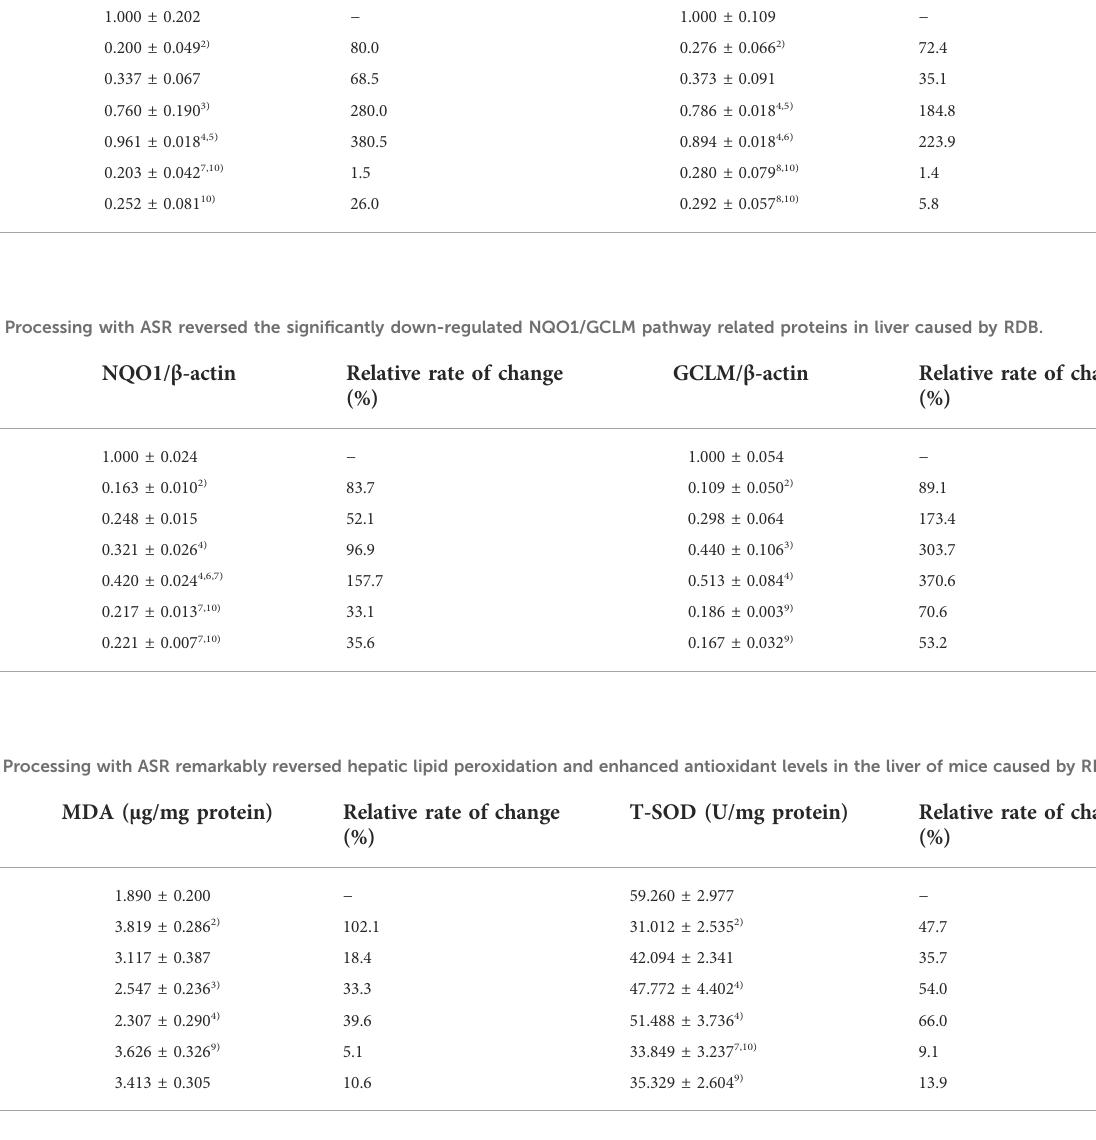
TABLE 5 Processing with ASR reversed the signi fi cantly down-regulated Nrf2/HO-1 pathway related proteins in liver caused by RDB. Group Nrf2/Lamin B Relative rate of change HO-1/ β -actin Relative rate of change (%) (%)